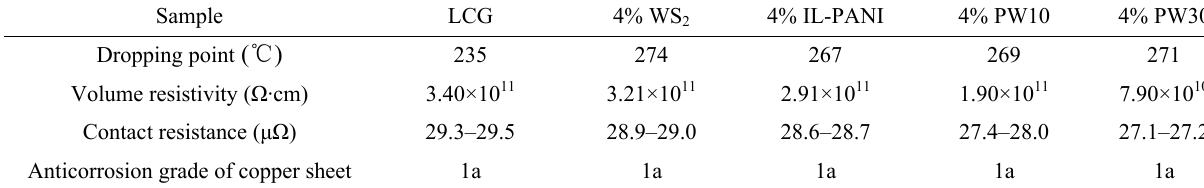
Table 2 Physical and chemical properties of greases.